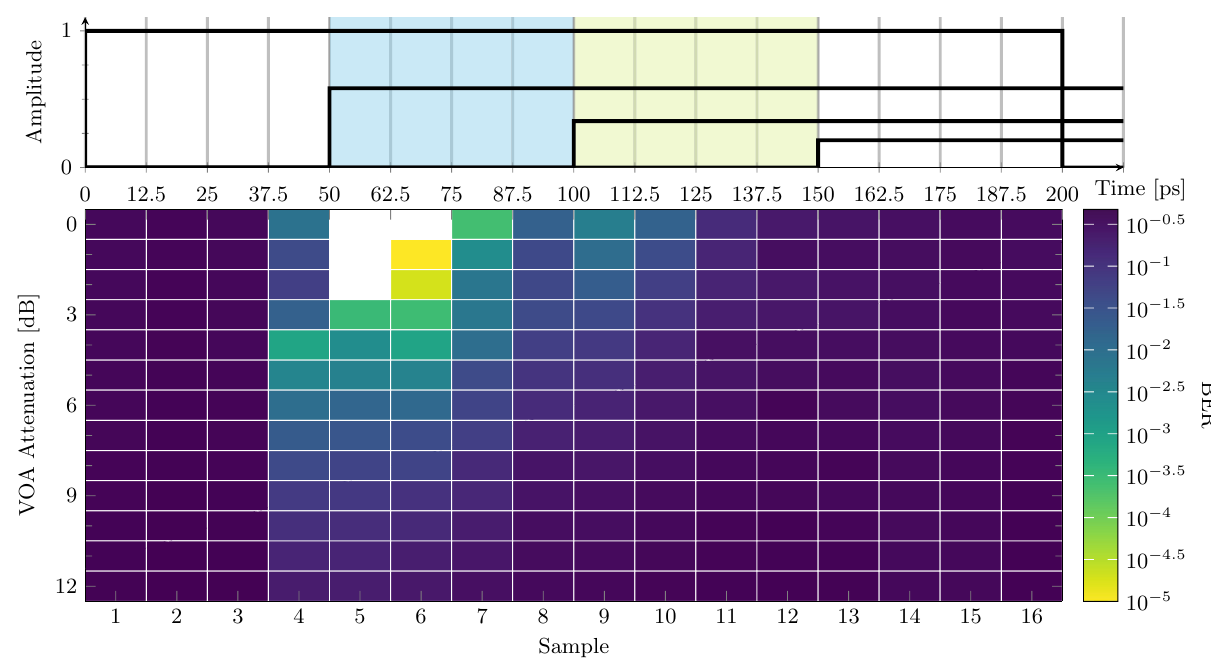
Figure 6. (Upper) Perceptron delayed inputs u i (black lines) as a function of time from the begin of the bit for an input equal to 01. The delayed copies are attenuated accordingly to the spirals losses. Vertical blue and green stripes identify the optimal working region. (bottom) 1-bit delay XOR at 5 Gbps. BER versus the time from the begin of the bit and VOA attenuation. Data at the best BER: VOA attenuation 0 dB, best sampling time 62.5 ps, insertion loss 9 dB, power at the detector 1.1 dBm, input power 4 dBm, BER statistical limit 10 − 5